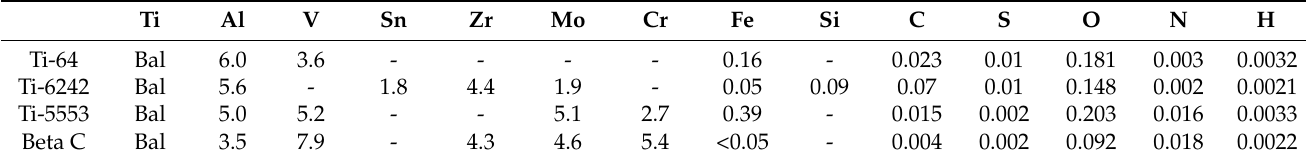
Table 2. Chemical composition from the elemental analysis of the powder feedstock used in this study in weight